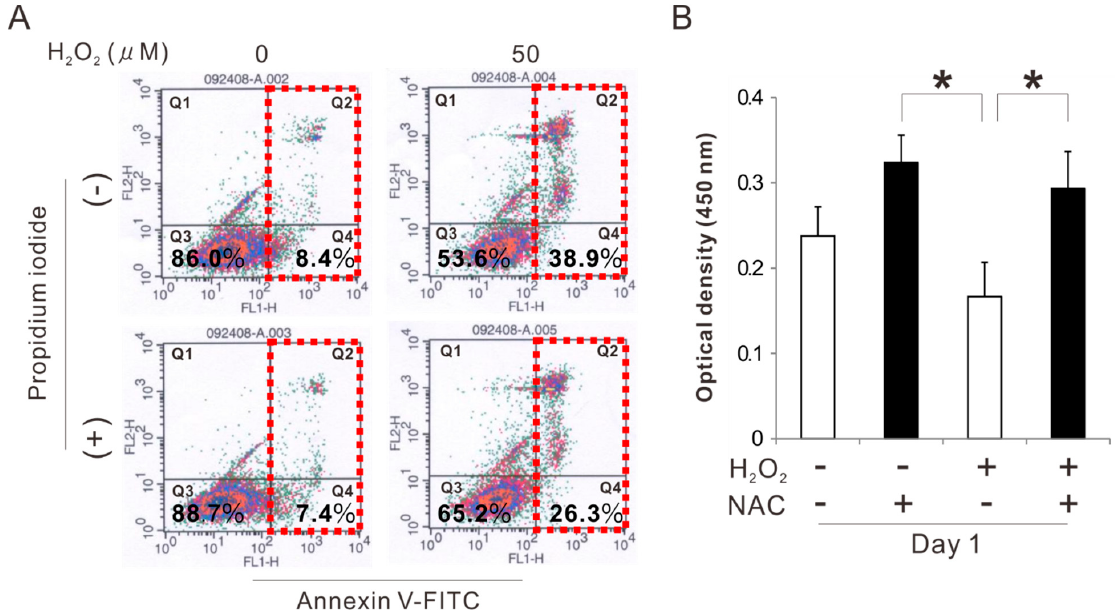
Figure 2. E ff ects of preconditioning osteoblast-like cells with N -acetyl- L -cysteine (NAC) on cell viability under oxidative stress. Rat femur bone marrow-derived osteoblast-like cells were preincubated with or without 5 mM NAC for 3 h and then cultured in an osteogenic di ff erentiation medium with and without exposure to 50 µ M H 2 O 2 . ( A ) Flow cytometry analysis for annexin V-fluorescein isothiocynate (FITC) and propidium iodide in the culture 24 h after seeding. The percentage of viable cells (Q3: quadrant 3); necrotic cells (Q1: quadrant 1); and apoptotic cells (within red-dashed enclosure), which is the sum of early (Q4: quadrant 4) and late (Q2: quadrant 2) apoptotic cells, is shown within each quadrant of the flow cytometric images. ( B ) Attached cell number evaluated by WST-1 colorimetry assay on day 1 culture. The data represent the mean ± standard deviation ( n = 3). Asterisks in 2B indicate statistically significant di ff erences ( p < 0.05, Tukey’s HSD